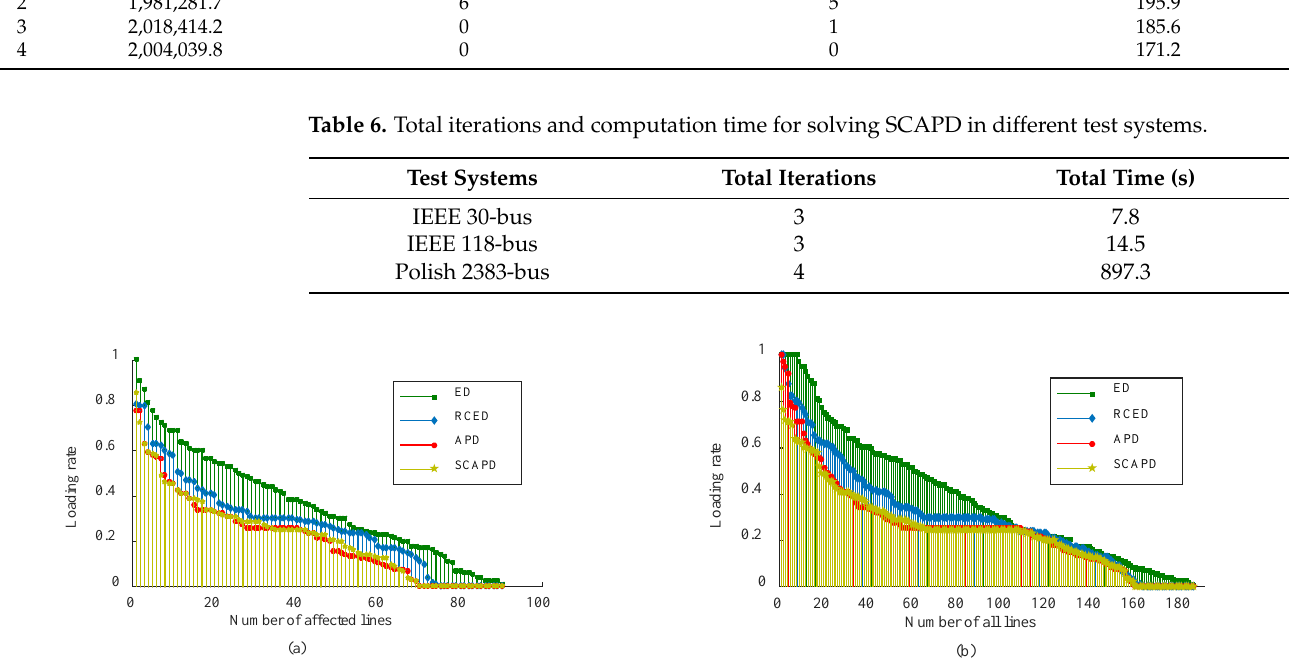
Figure 4. Loading rates for ( a ) lines affected by extreme weather and ( b ) all lines ranked from highest to lowest of the IEEE 118-bus system.